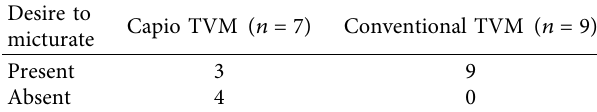
Table 2: Urge to urinate postoperatively.